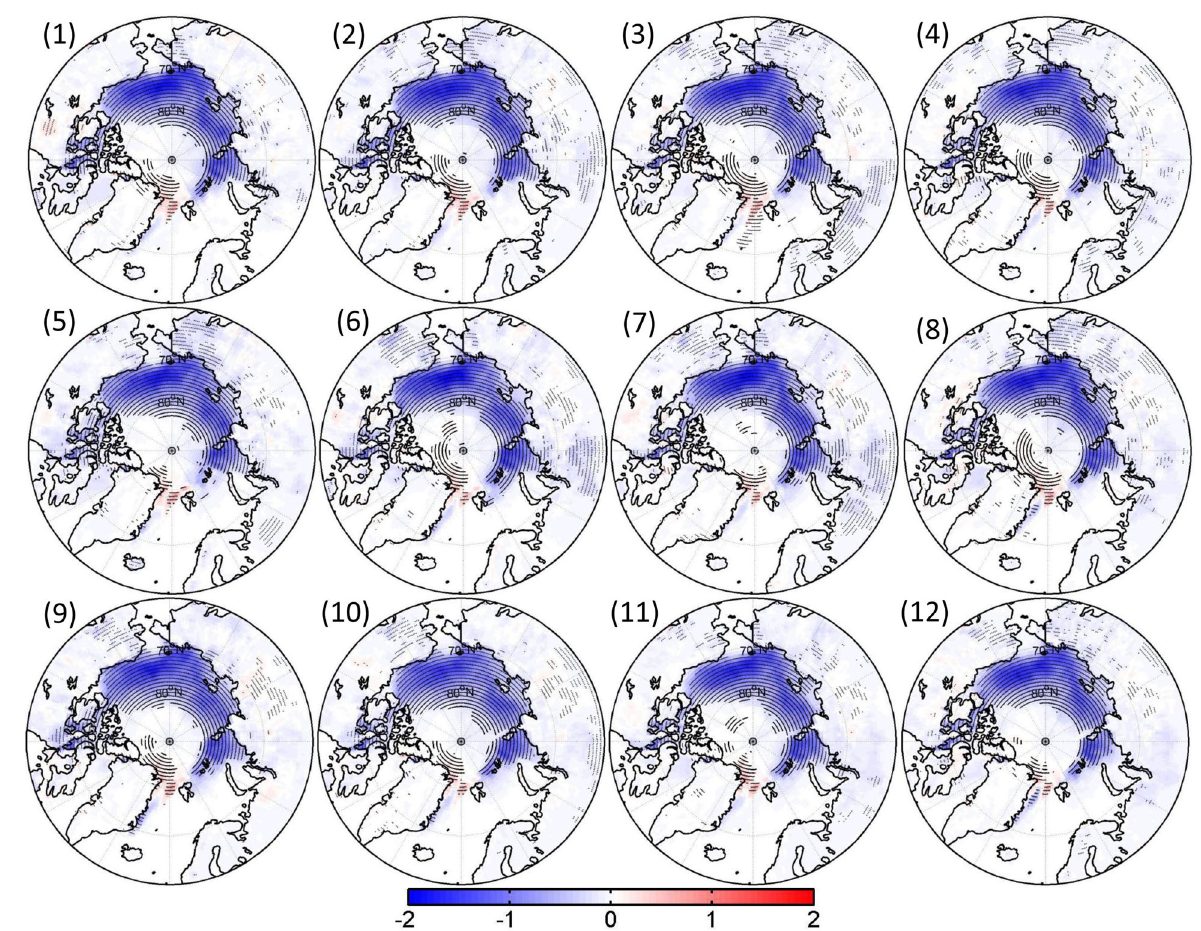
Fig. 13 Trend in albedo for each node (unit: % yr − 1